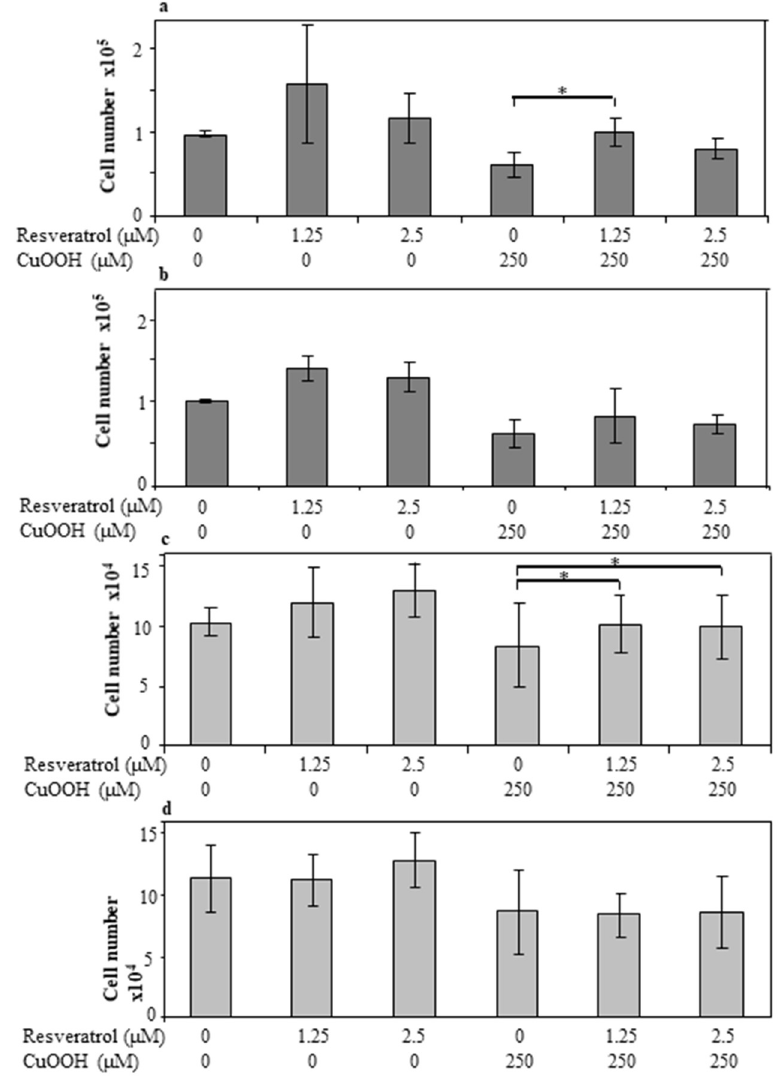
Figure 5. Effect of trans-resveratrol (panel ( a )) and diastereomeric mixture (panel ( b )) treatment on cell numbers evaluated by the measuring fluorescence. Horizontal bars indicate a statistically significant difference (*: p < 0.05). Effect of trans-resveratrol (panel ( c )) and diastereomeric mixture (panel ( d )) treatment on cell proliferation evaluated by Alamar Blue assay. Horizontal bars indicate a statistically significant difference (*: p < 0.05).